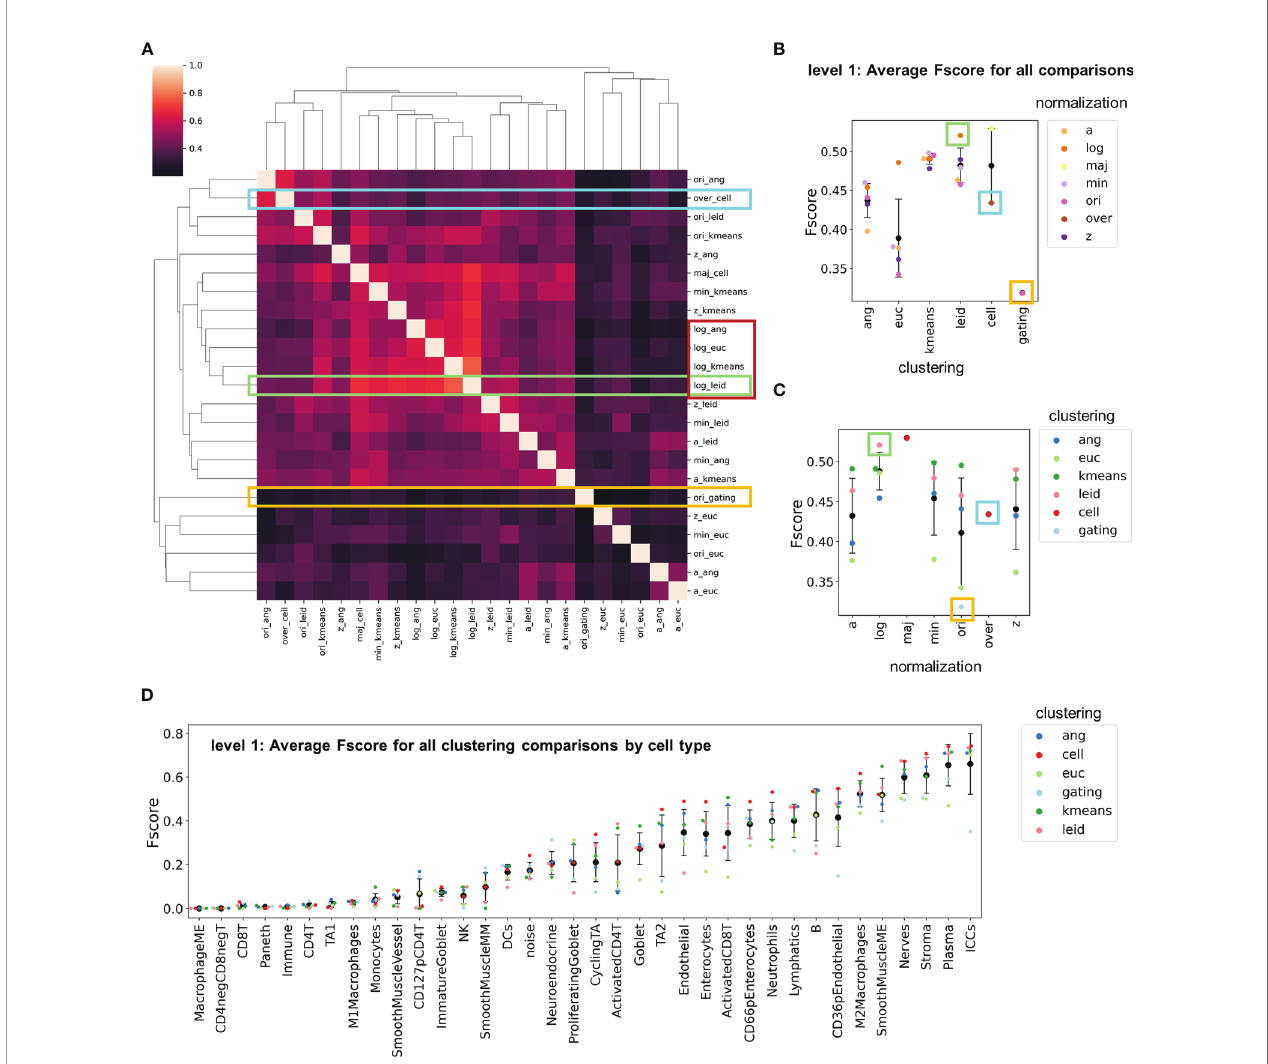
FIGURE 5 | F-score comparisons between all clustering and normalization techniques as standards. (A) Clustered heatmap with F-scores averaged across cell types. The yellow rectangle indicates the comparisons made in Figure 3 , the cyan rectangle indicates the comparisons made in Figure 4 , and the green rectangle indicates the comparisons made when log double Z normalization combined with Leiden clustering was used as the gold standard. The red rectangle indicates exemplary similarities between normalization techniques. (B, C) Level 1 F-scores averaged over cell types for (B) clustering and (C) normalizations for all comparisons shown in panel (A, D) Level 1 F-scores averaged over cell types for all normalization and clustering combinations (black data point is mean and error bars indicate standard